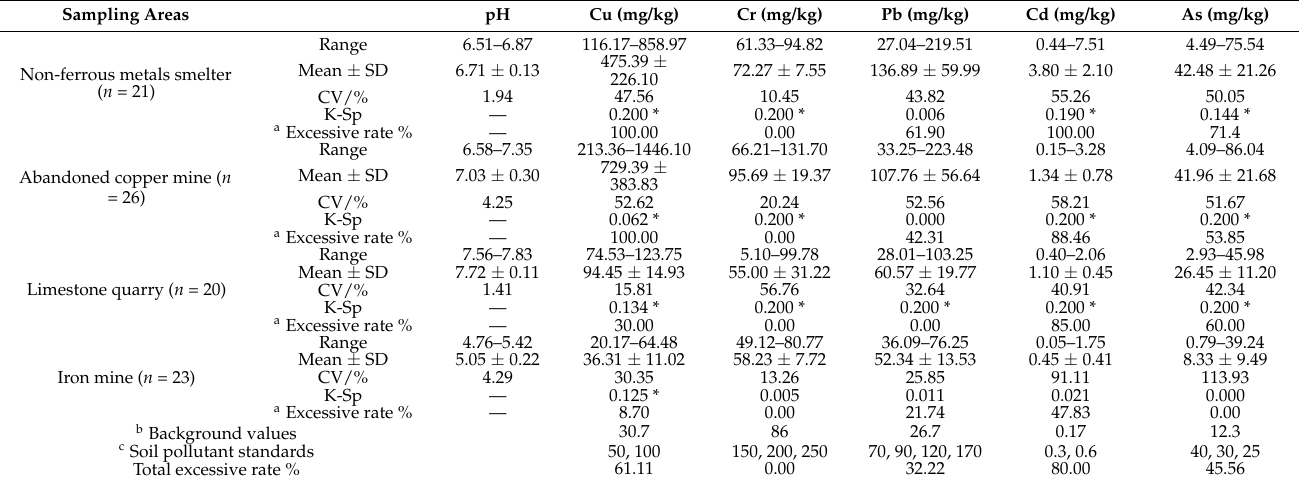
Table 2. Characteristics of heavy metals in soils of the four typical zones.